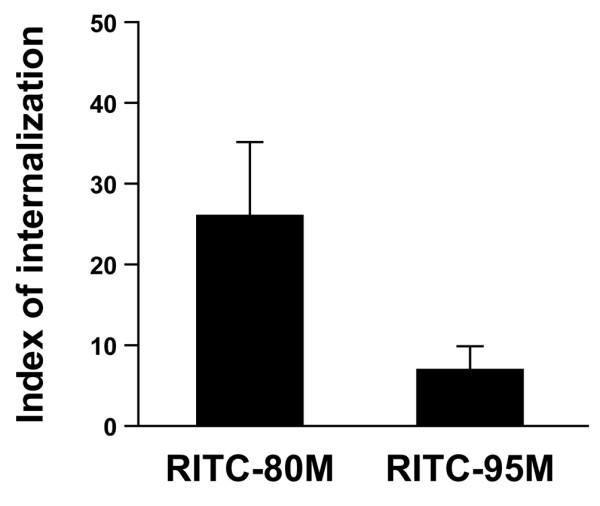
The internalization of chitosan by PMNs. Freshly isolated polymorphonuclear neutrophils (PMNs) were resuspended in RPMI 1640 supplemented with 0.1% decomplemented fetal bovine serum, pre-stained with 1 μg/ml calcein-AM for 30 minutes at 37°C and incubated with 100 μg/1 × 106 cells rhodamine B isothiocyanate (RITC)-zymosan for 1.5 hours (a positive control), 15 μg/ml RITC-80% deacetylated (80 M) or RITC-95% deacetylated (95 M) chitosan for 3 hours at 37°C. PMNs were then centrifuged and plated on a slide coated with 100% decomplemented autologous serum and visualized by live confocal microscopy. The index of internalization of chitosan by PMNs was calculated as the percentage of cells that internalized RITC-chitosan. Results are presented as mean ± standard error. This figure represents the results of three independent experiments.